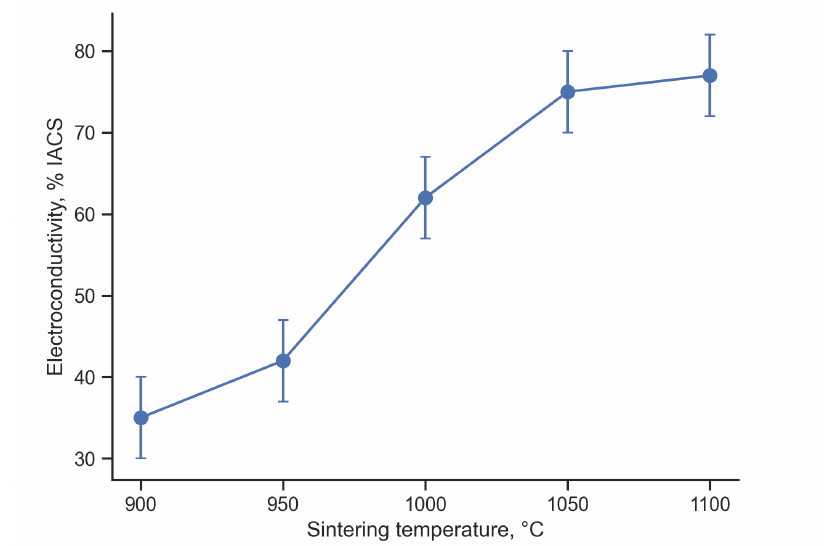
Figure 6. Electroconductivity in terms of % IACS of Ti 3 AlC 2 : Cu (1:1)